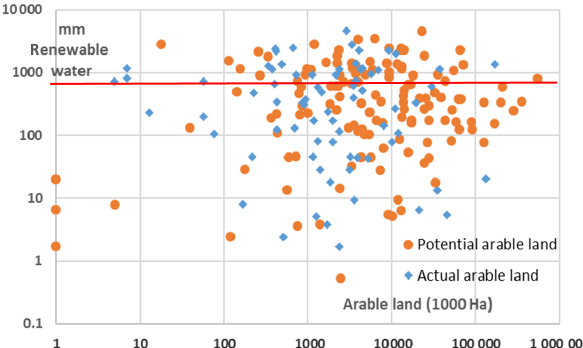
Figure 7. Renewable water resources (mm of water per year) and arable land available by country. Diamonds show actual arable land and circles show potential arable land. The horizontal line divides countries with and without enough water to fully utilise their arable